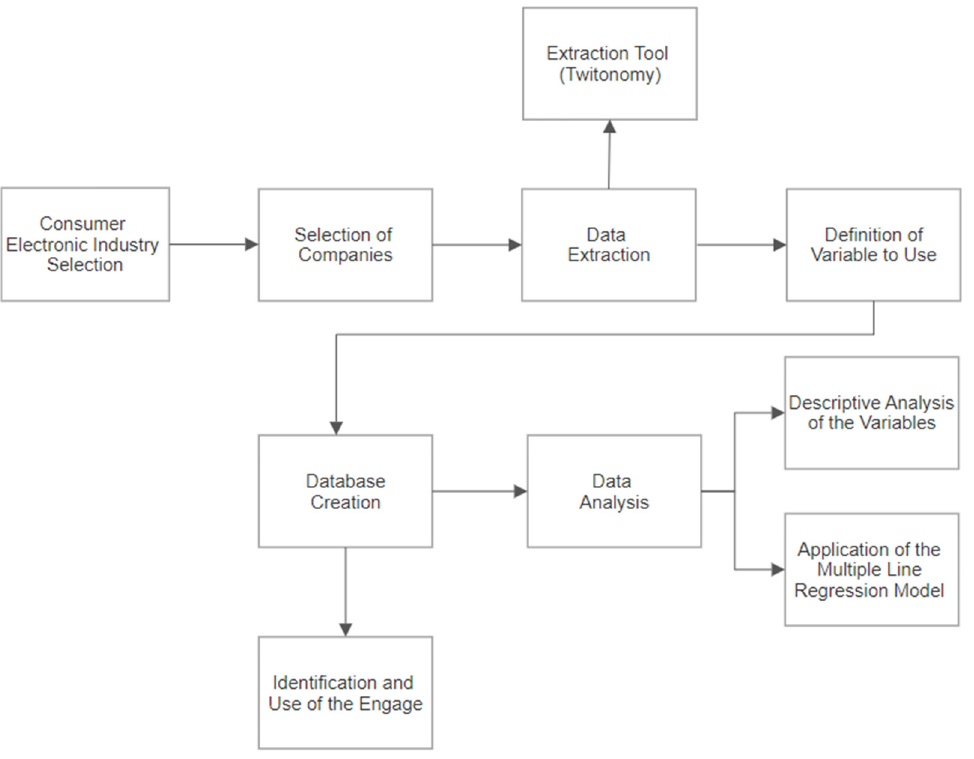
Figure 1. Methodological flow of the research.